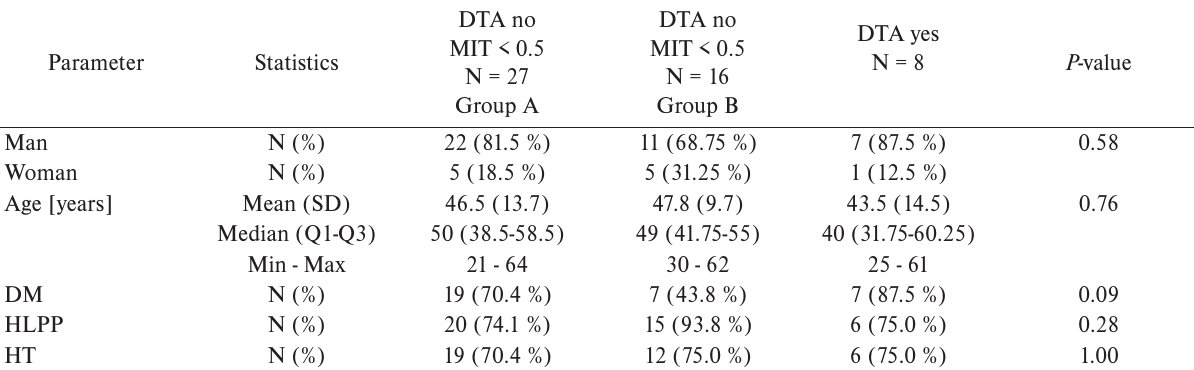
Table 2. Basic characteristics and breakdown of allograph recipients based on IVUS examination results one year after HTx.